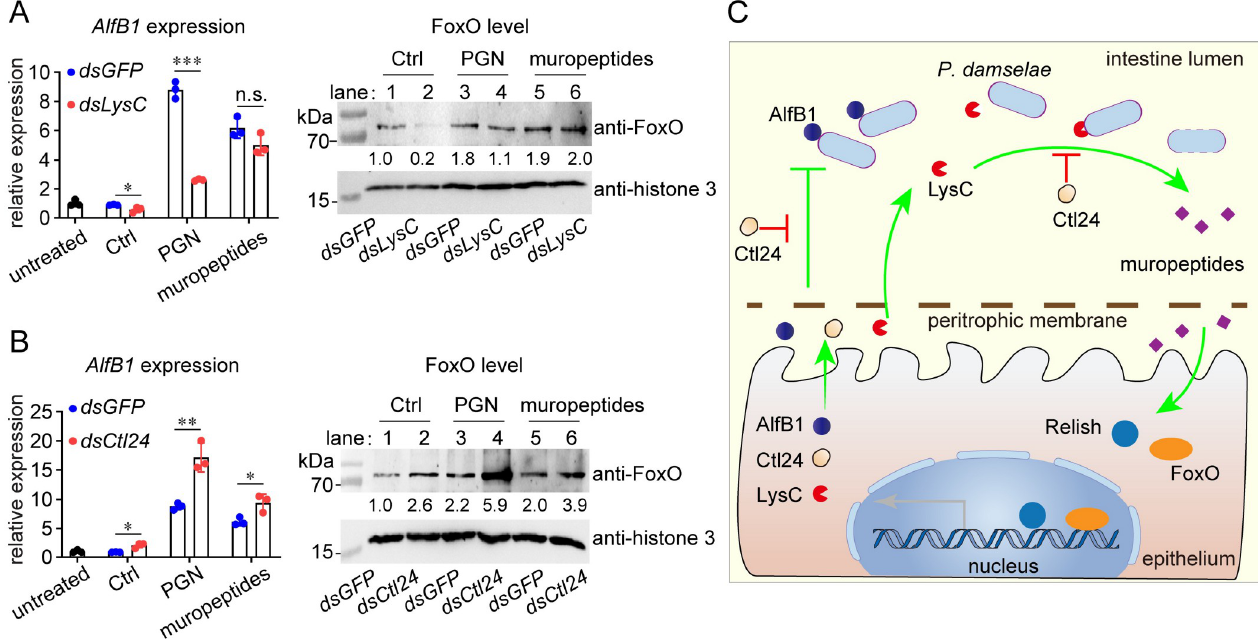
Fig 7. Coordination of LysC and Ctl24 in PGN-derived intestinal immunity. (A) Requirement of LysC for PGN, but not muropeptides, to induce intestinal immunity. PGN or muropeptides (5 μ g) were administered into shrimp intestine at 24 h after dsRNA application. AlfB1 expression (left panel) and FoxO nucleus level (right panel) was detected 6 h later. (B) Requirement of Ctl24 to counteract the intestinal immunity induced by either of PGN and muropeptides. (C) Model of the coordination among immune effectors in intestinal immunity. LysC cleaves intestinal bacterial PGN into muropeptides, which activate both FoxO and Relish to induce the expression of three immune effectors. Coating of bacteria by Ctl24 inhibits the PGN-processing ability of LysC, and inhibits the bactericidal activity of AlfB1. The bar charts show the mean ± SD from three replicates. The images are representative of three repeats. Statistical analysis was performed using the Students’ t test. � , 0.01 < p < 0.05; �� , 0.001 < p < 0.01; ��� , p <